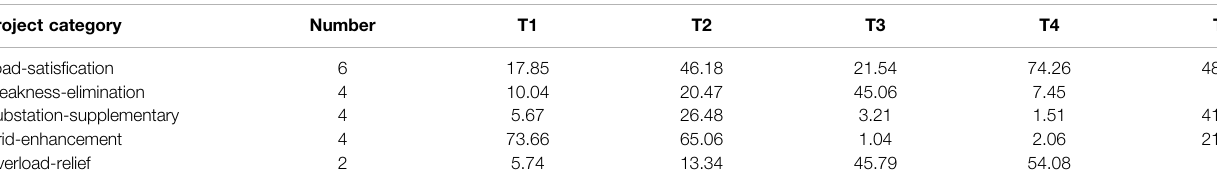
TABLE 5 | Statistics of various